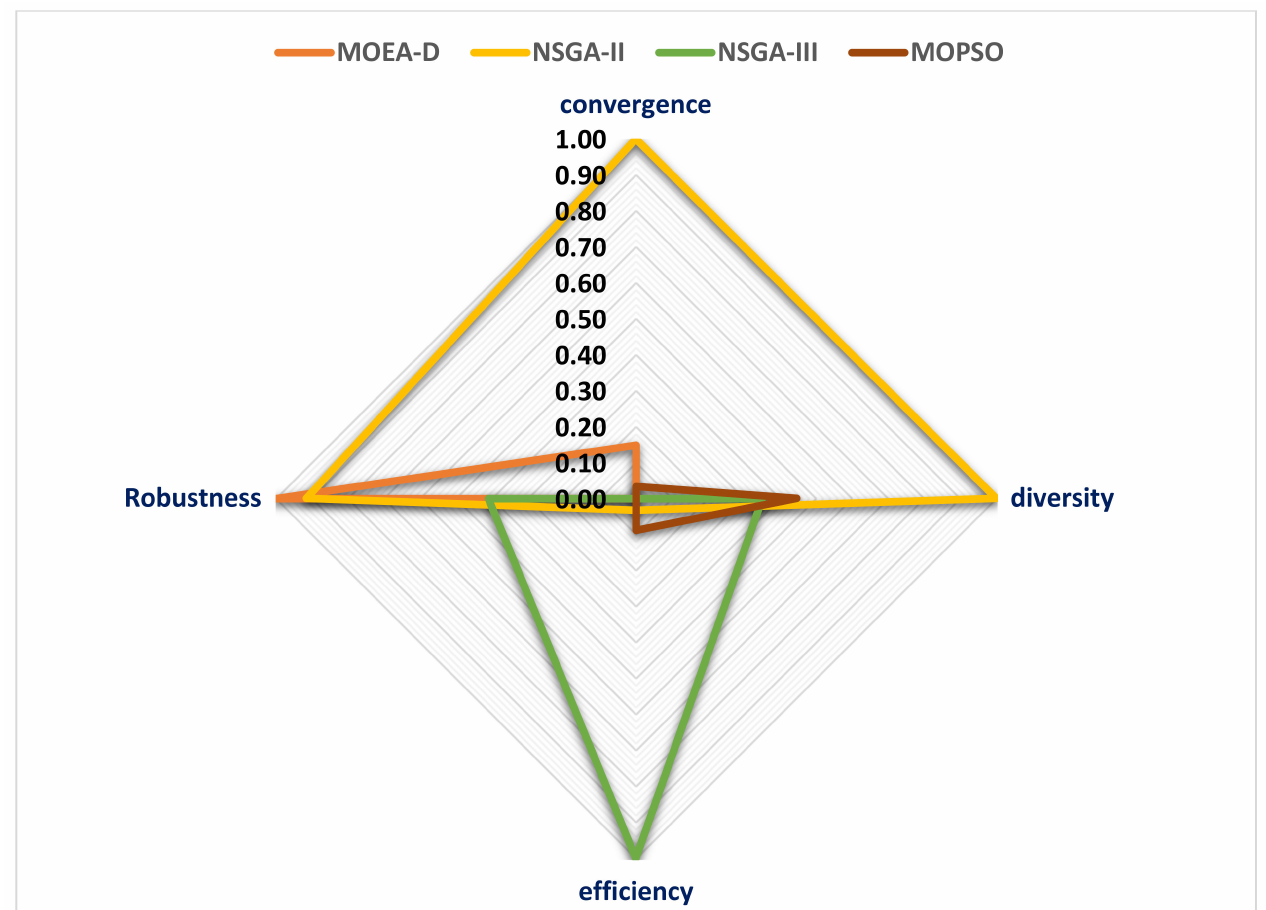
Figure 9. The performance indicators for the four proposed